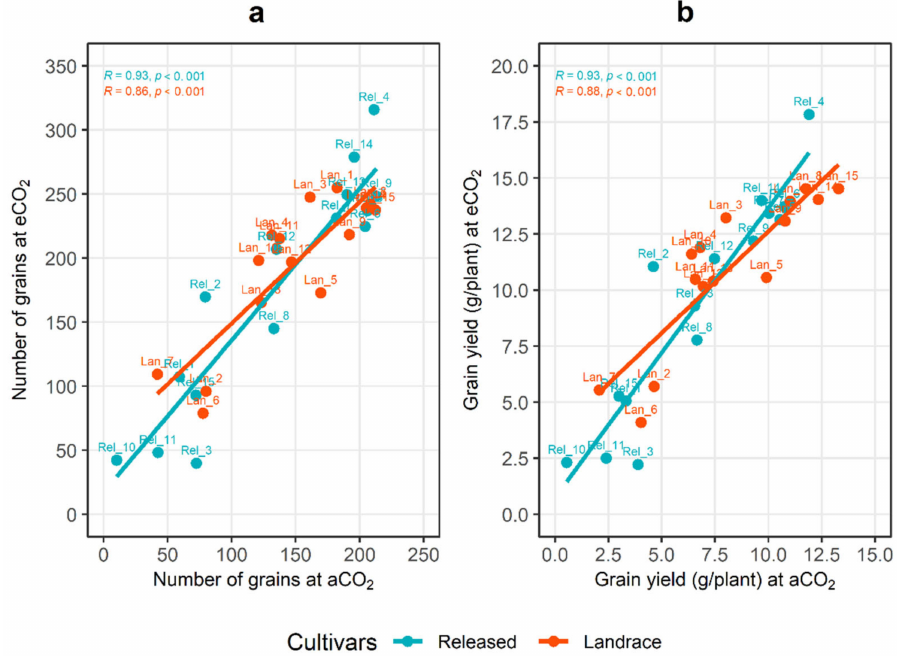
Figure 3. Mean response of landrace and released cultivars under elevated (500 ppm) CO 2 plotted against mean response under ambient (400 ppm) CO 2 , where responses refer to ( a ) number of grains per plant and ( b ) grain yield (in grams) per